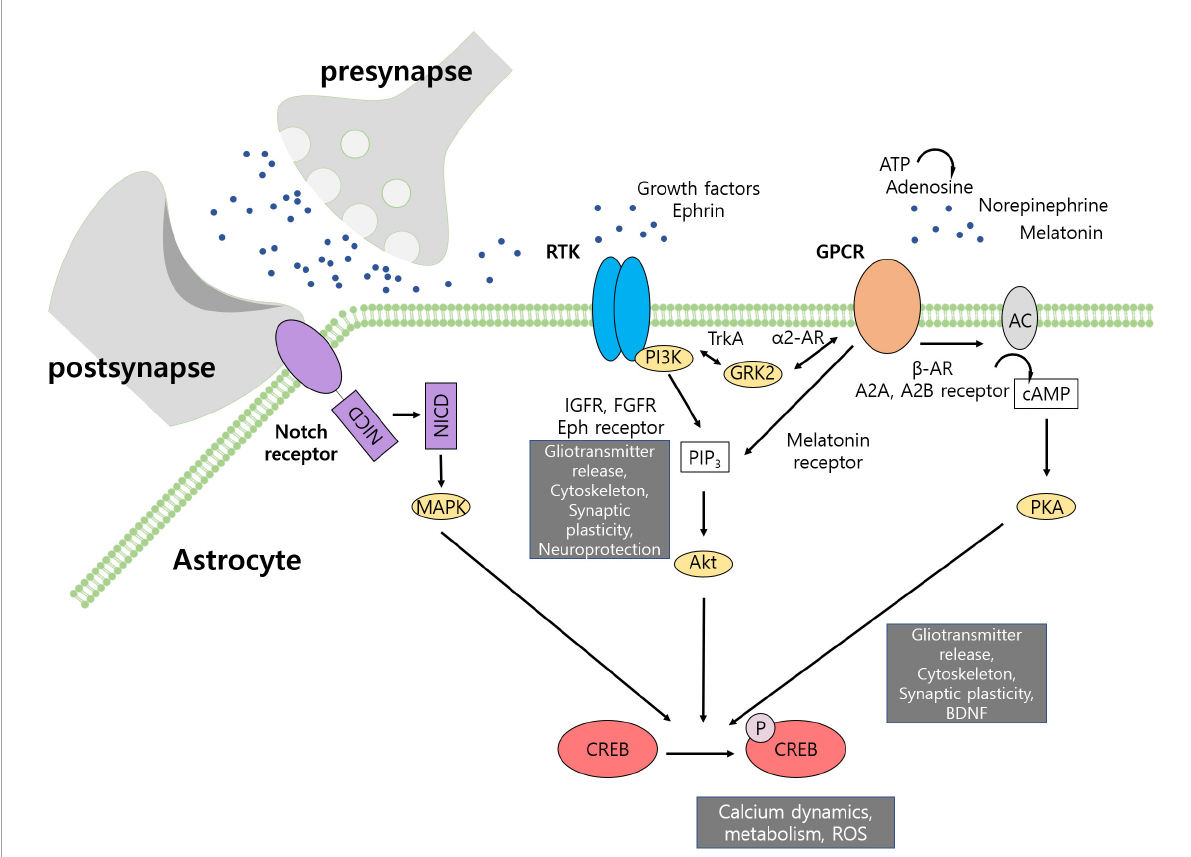
FIGURE1 Activation of CREB pathway in astrocyte. CREB activity regulates gliotransmitter release, cytoskeleton dynamics, synaptic plasticity, neuroprotection, growth factor release, calcium dynamics, metabolism, and generation of reactive oxygen species. Receptor tyrosine kinases produce PIP 3 to activate Akt that can phosphorylate CREB. GPCRs can activate adenylyl cyclase to produce cAMP and activate PKA. Some GPCRs, such as melatonin receptor, can activate CREB via Akt. Notch intracellular domain is cleaved upon activation by contact-dependent signals and may activate MAPK